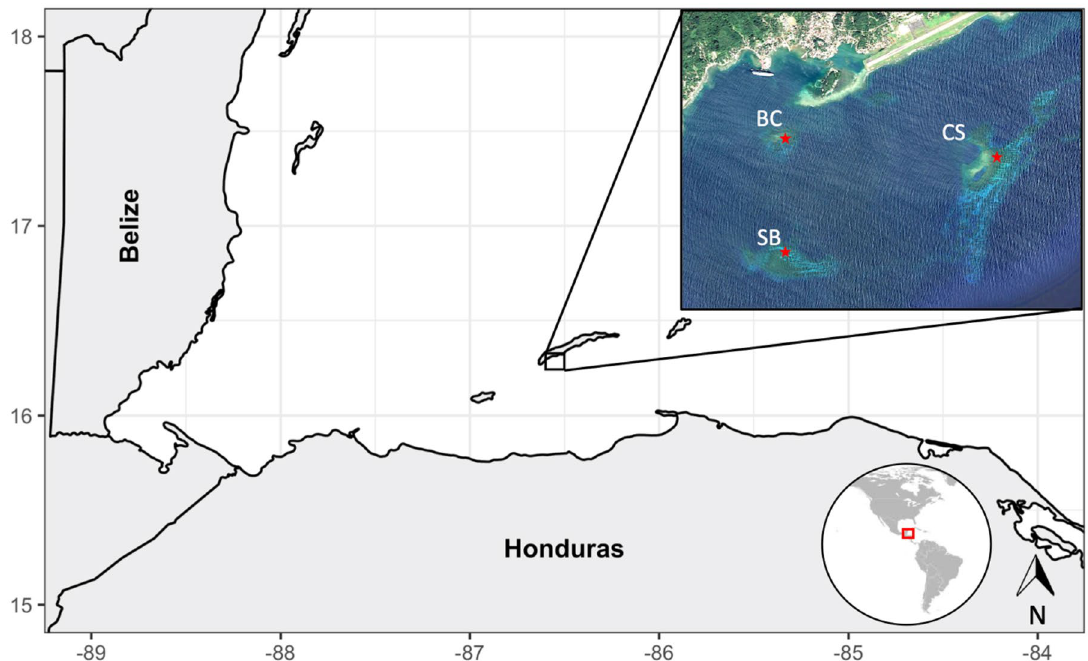
Figure 1. Map of the Honduran north shore, highlighting the location of Cordelia Bank Site of Special Importance to Wildlife, and the three banks with dense thickets of Acropora cervicornis , BC—Big Cay, CS— Cordelia Shoal, SB—Smith Bank, approximate sampling locations are indicated by red stars. Maps were created with R Studio version 1.2.1335 37 using satellite images provided by Google